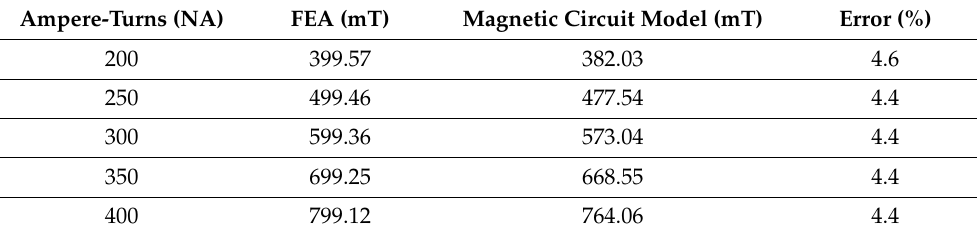
Table 3. The comparison of finite element simulation and modeling calculation results of axial single-coil